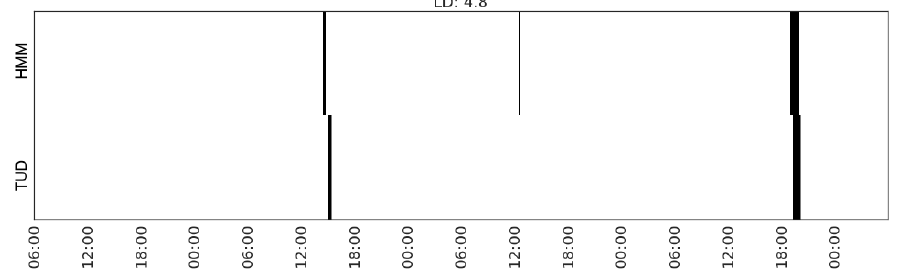
Figure 16. Recognising the activity of watching TV in Household 2 with feature set